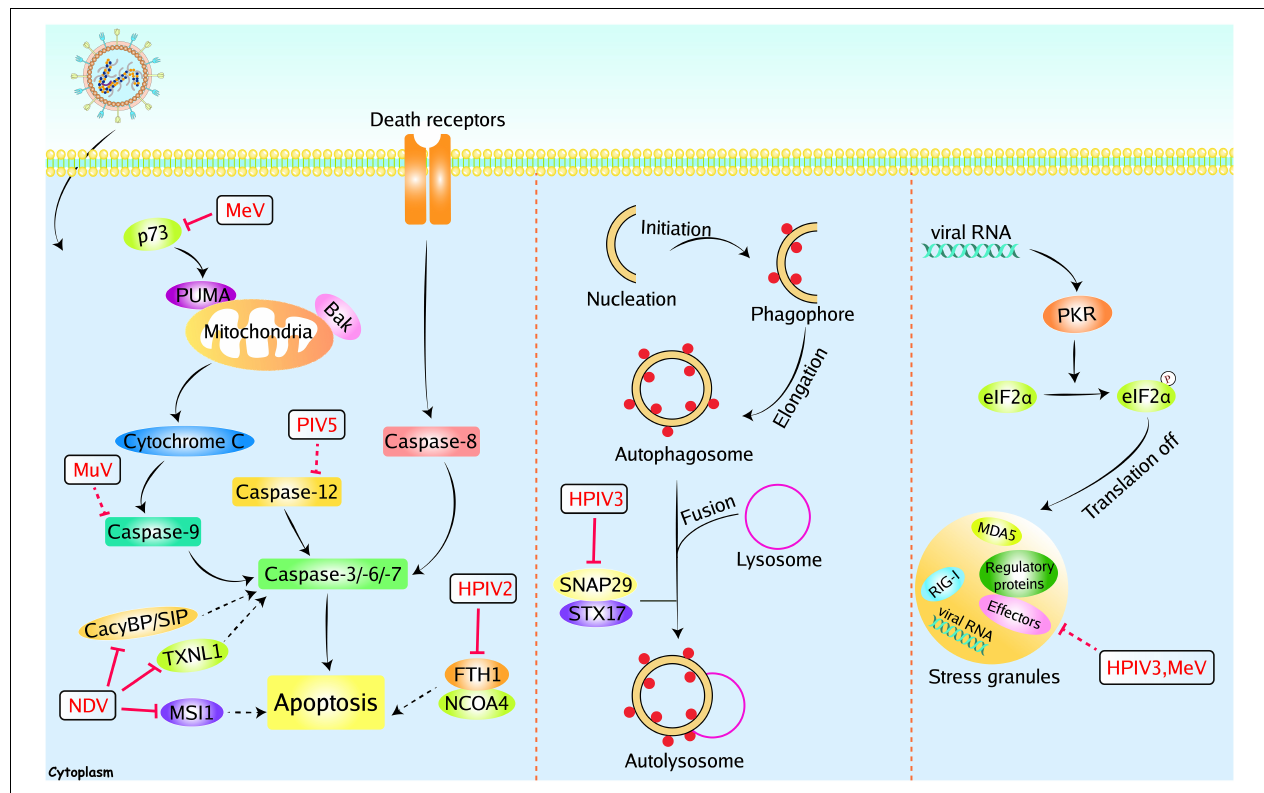
FIGURE 4 | Paramyxoviruses accessory proteins-mediated evasion of apoptosis, autophagy, and SGs. Paramyxoviruses infection could induce other immune responses, including apoptosis, autophagy, and SGs to restrict viral replication. However, these immune responses can be manipulated by paramyxoviruses accessory proteins. The V proteins of NDV could inhibit apoptosis by interacting with CacyBP/SIP, TXNL1, or MSI1. The P protein of MeV could inhibit apoptosis with unknown mechanisms, and the MeV V protein could inhibit p73. The MuV V and PIV5 V protein could inhibit caspase 9 and caspase 12, respectively. The HPIV2 V protein could inhibit FTH1. The P protein of HPIV3 could inhibit autophagy through interacting with SNAP29. The P protein of HPIV3 and MeV C protein could inhibit stress granules (SG). Red solid lines indicate confirmed interactions between adaptors and accessory proteins, and red dashed lines indicate uncertain interactions or unknown underlying mechanisms; P,